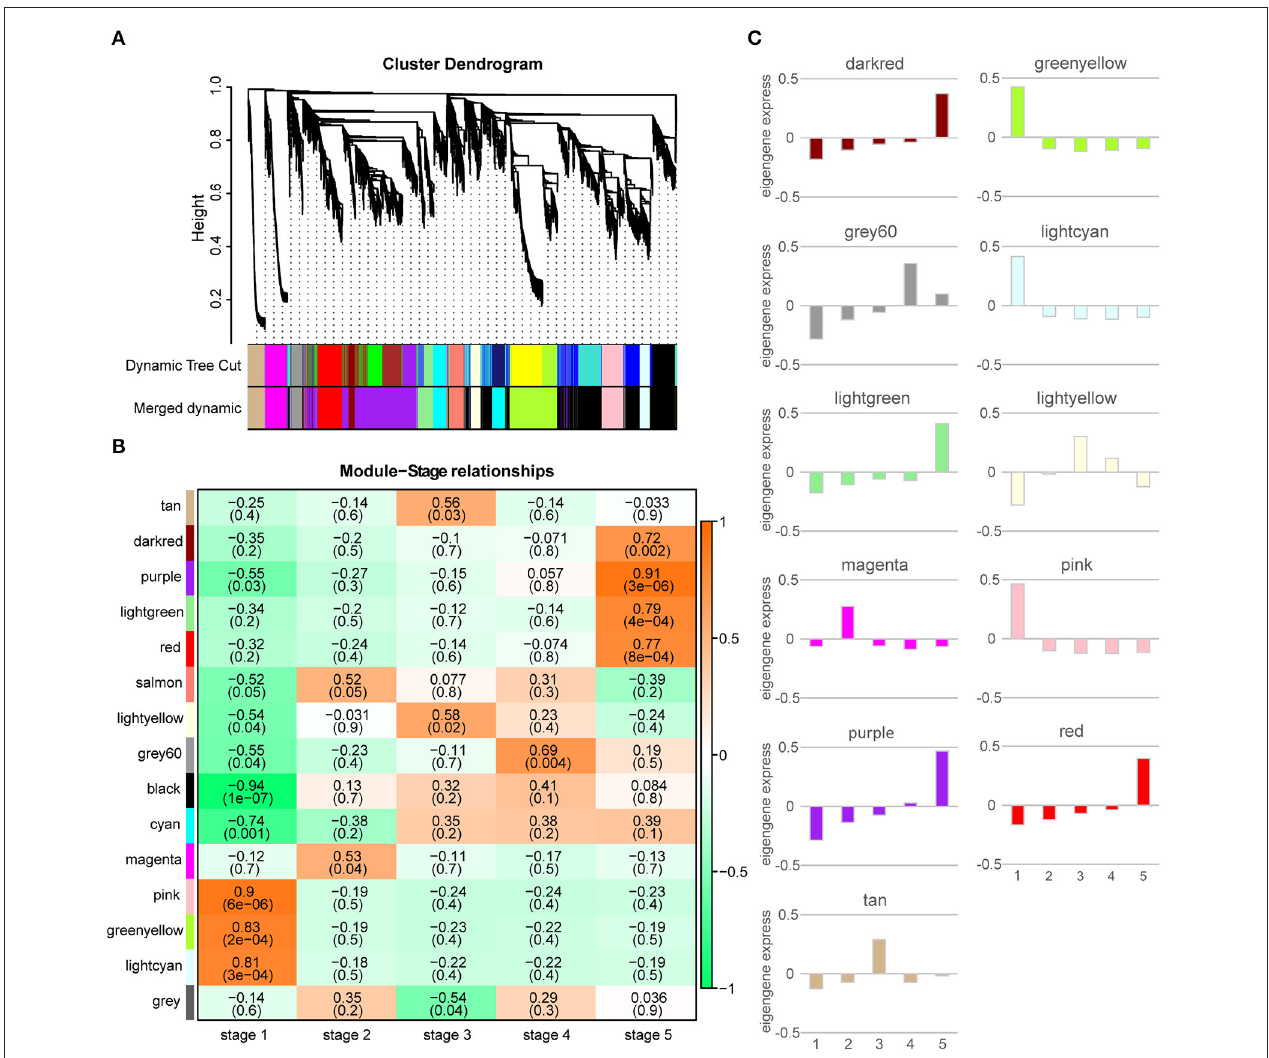
FIGURE 5 | Weighted gene co-expression network analysis (WGCNA) of the significantly changed transcripts. (A) Hierarchical cluster tree showing co-expression modules and merged modules identified by the WGCNA. Each leaf in the tree is one gene. The dynamic tree cut were modules divided according to the clustering results, and merged dynamic were modules that were merged with a similar representation pattern based on module similarity. The major tree branches constitute 15 merged modules labeled with different colors. (B) Module-stage relationships. Each row corresponds to a module, and each column represents a specific stage. The color of each cell at the row-column intersection indicates the correlation coefficient between a module and a stage. A high degree of correlation between a specific module and stage is indicated by red. (C) Eigengene expression profile of each module. The y-axis indicates the value of the module eigengene; the x-axis indicates the sampled post-germination stage